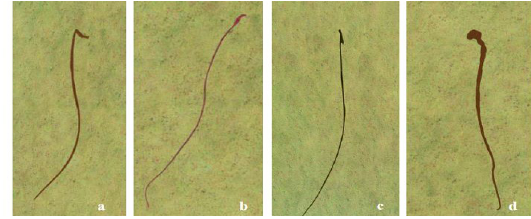
Fig 1. Types of sperm head abnormalities in rat treatment with